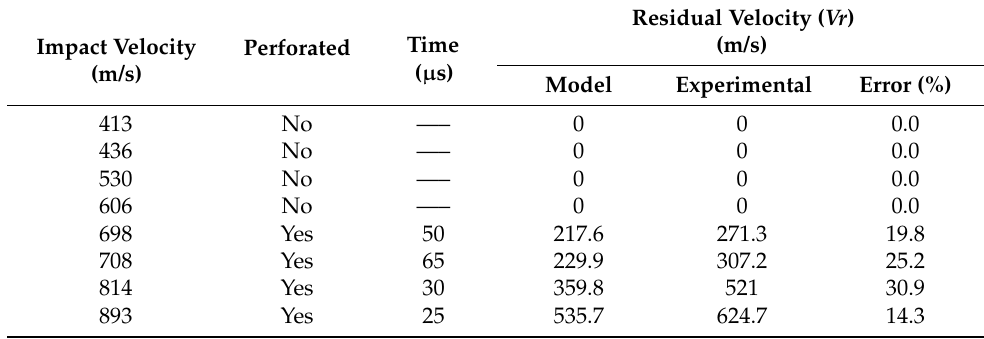
Table 6. Calibrated case’s ballistic simulation results (Vr) compared to the experimental results.